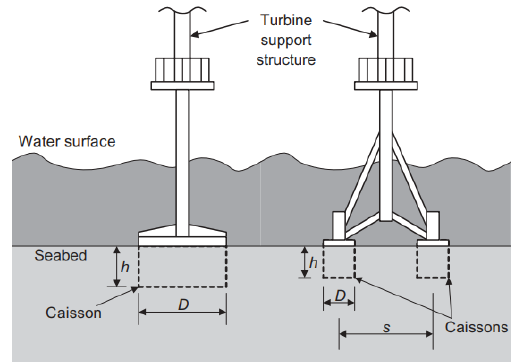
Figure 3. Example of monopod and tripod suction caisson foundations [20].